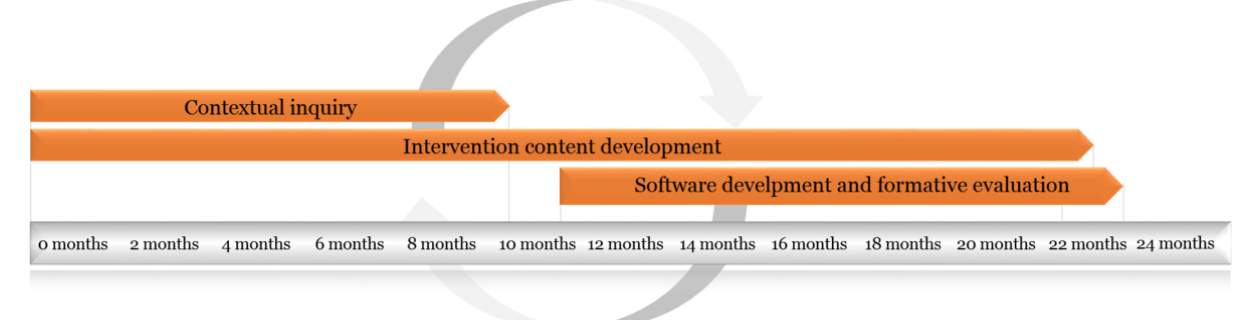
Figure 1. Study overview and development